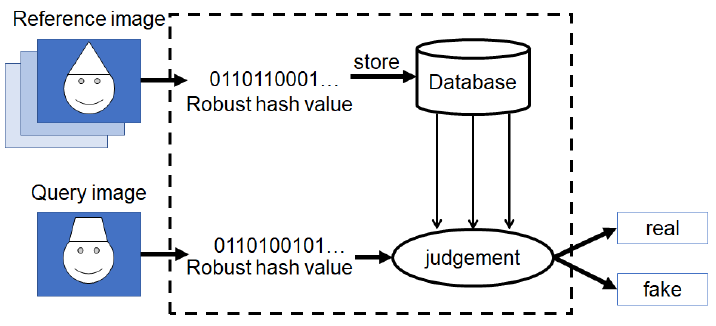
Figure 3. An overview of the proposed